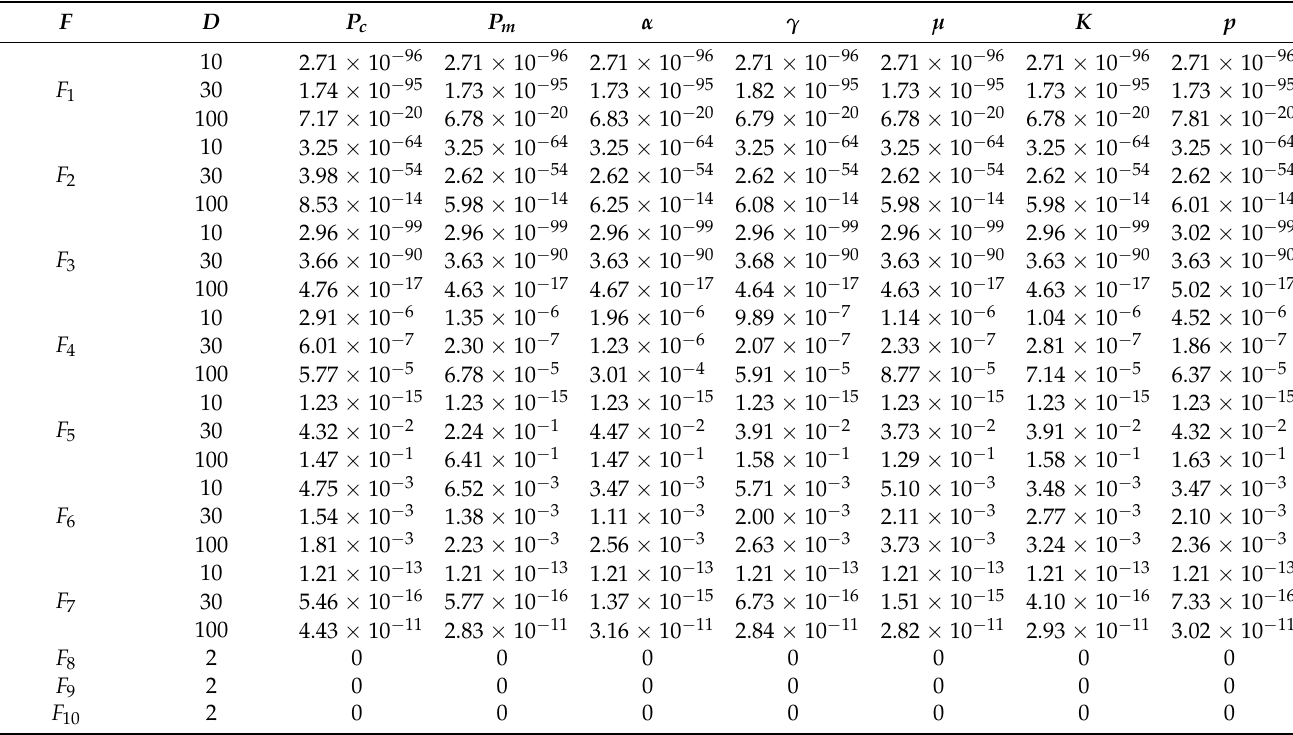
Table 4. Standard deviations of orthogonal